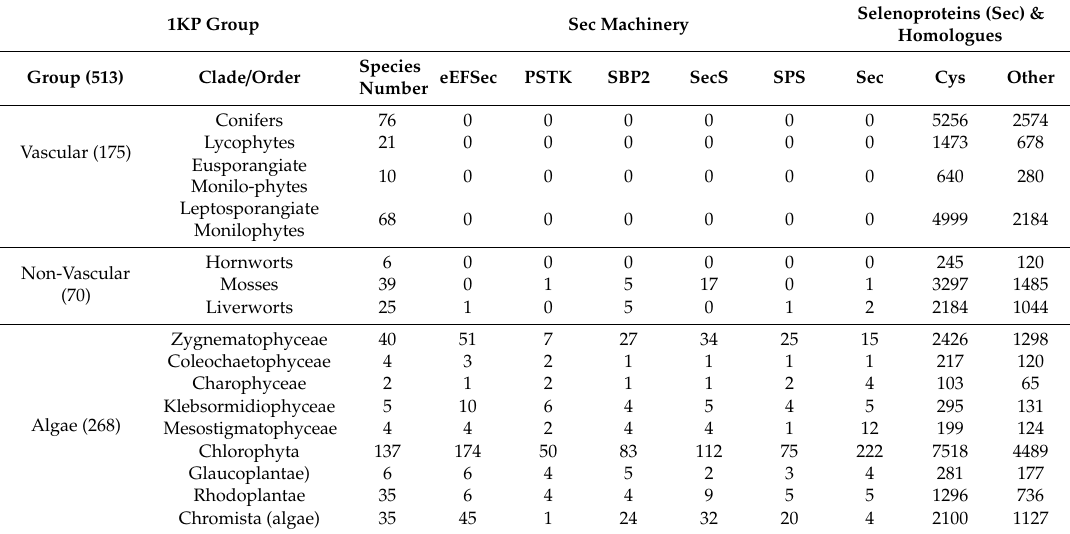
Table 1. Number of enzymes involved in the Sec incorporation machinery and selenoproteins. The number of enzymes of the Sec incorporation machinery and selenoproteins are detected by Selenoprofiles across the sequenced algae, liverworts, mosses, hornworts and a part of lower embryophyte genomes and transcriptomes (from the 1 KP